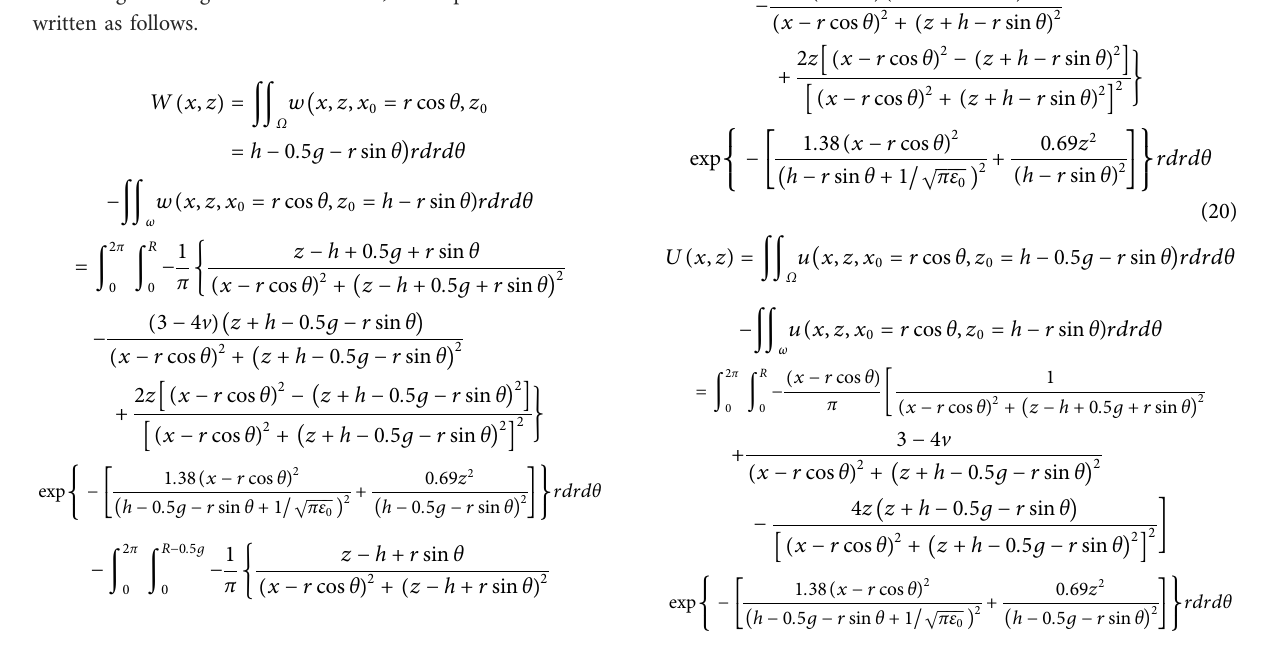
Equivalent ground Excavated Depth of Poisson ’ s Soil Elastic loss parameter, diameter, tunnel ratio weight, modulus, γ g D (m) center, of soil, E u (MPa) ν h (m) (kN · m − 3 )